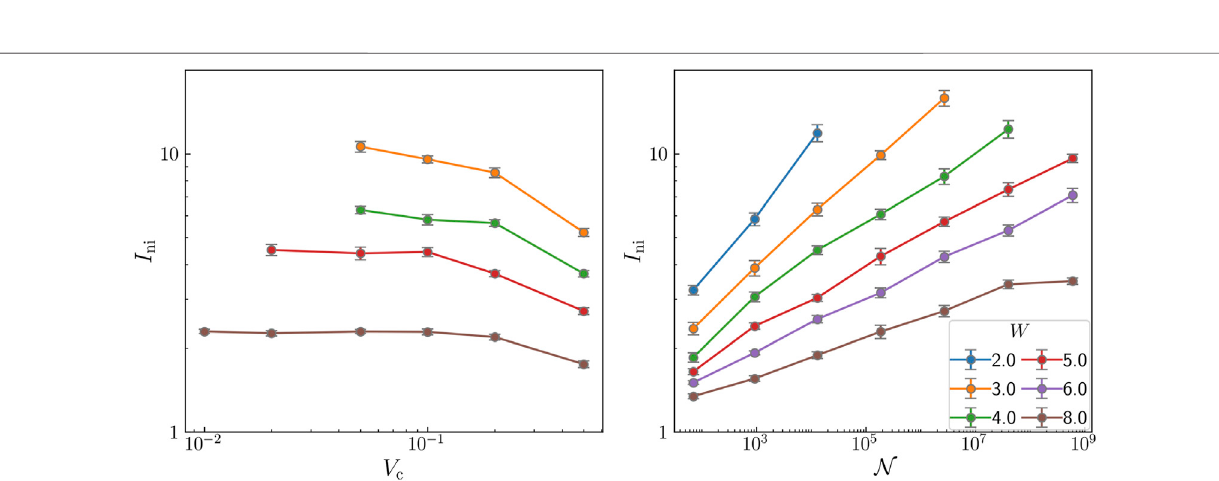
Frontiers in Physics |